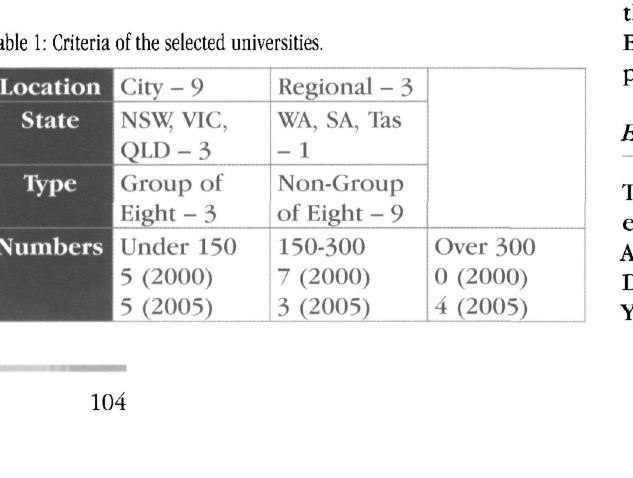
Table 1: Criteria of the selected universities. Location City -